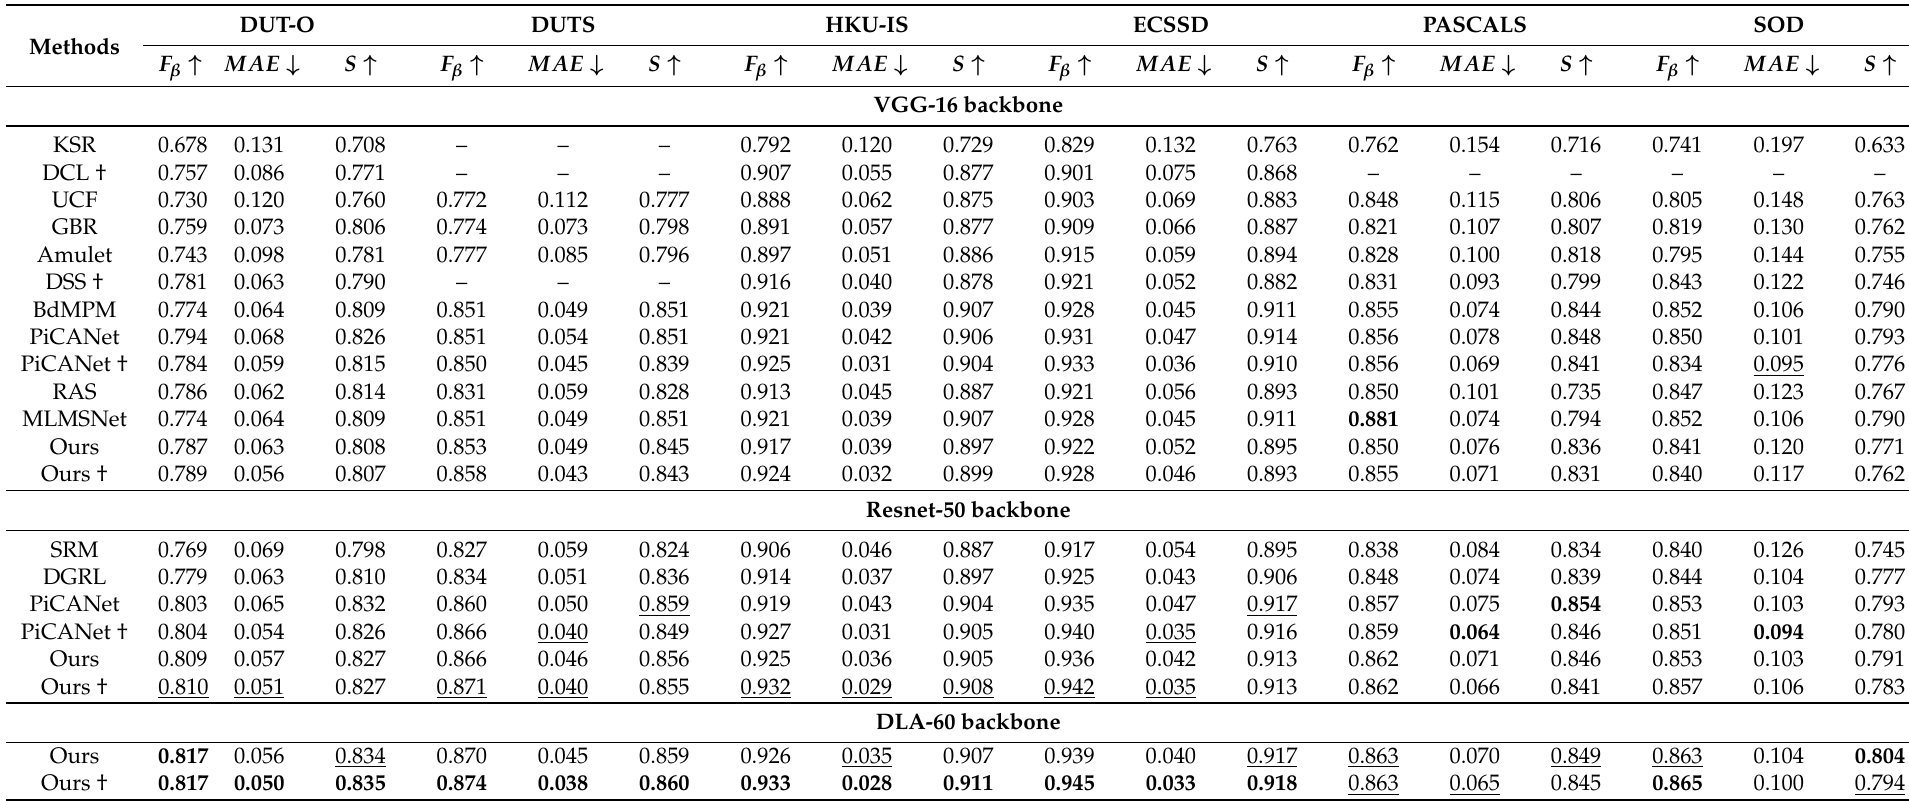
Table 3. Comparison of different salient object detection (SOD) methods on six datasets. The best performance is boldfaced and the second best is underlined. † means that the method is postprocessed by Conditional Random Field